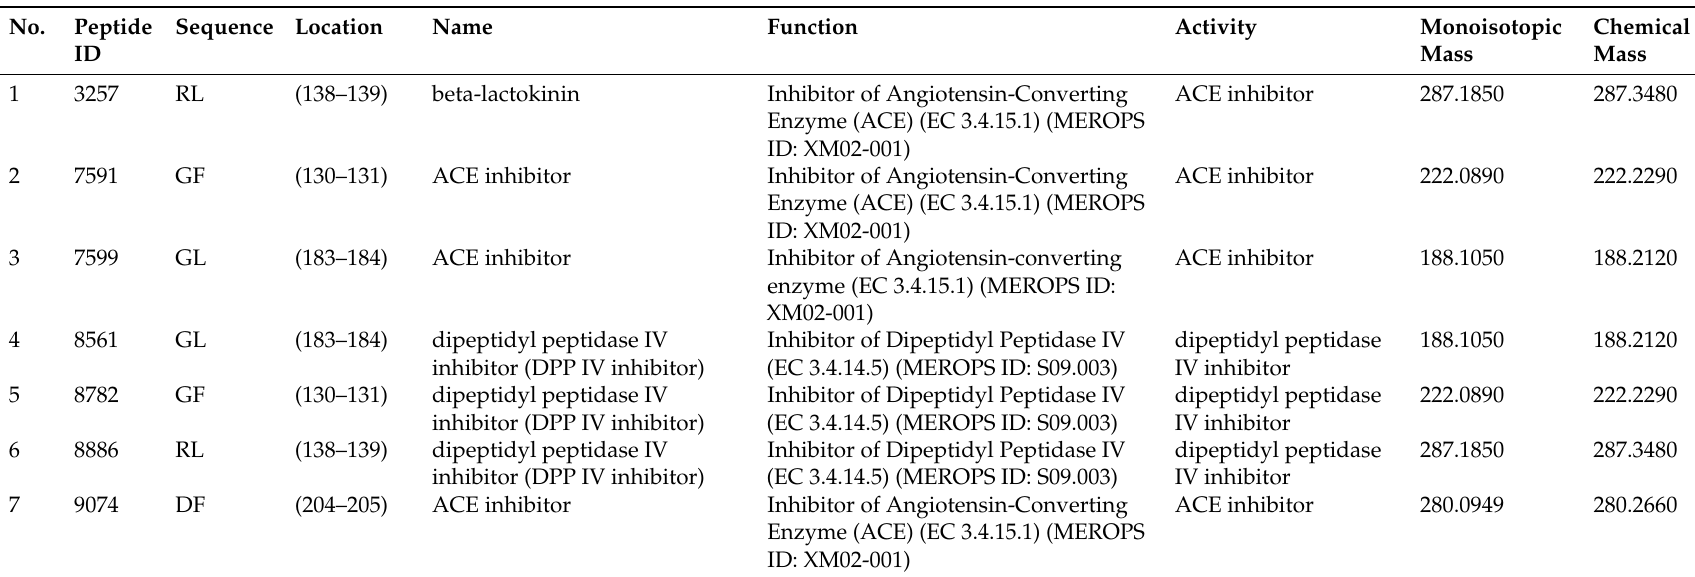
Table A5. Bioactive peptides from RubisCO of Halophila stipulacea . In silico enzymatic cleavage was carried out by using